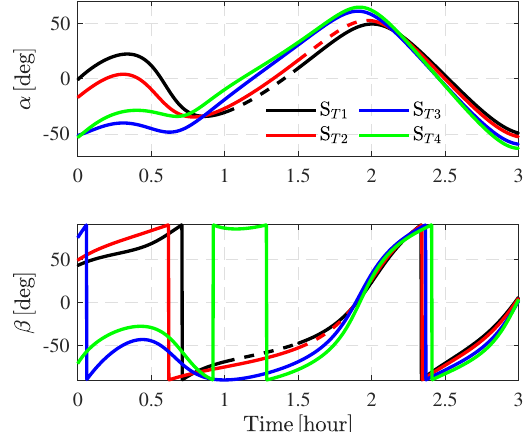
Figure 7. Time history of the two angular measurements considering invisible arcs.